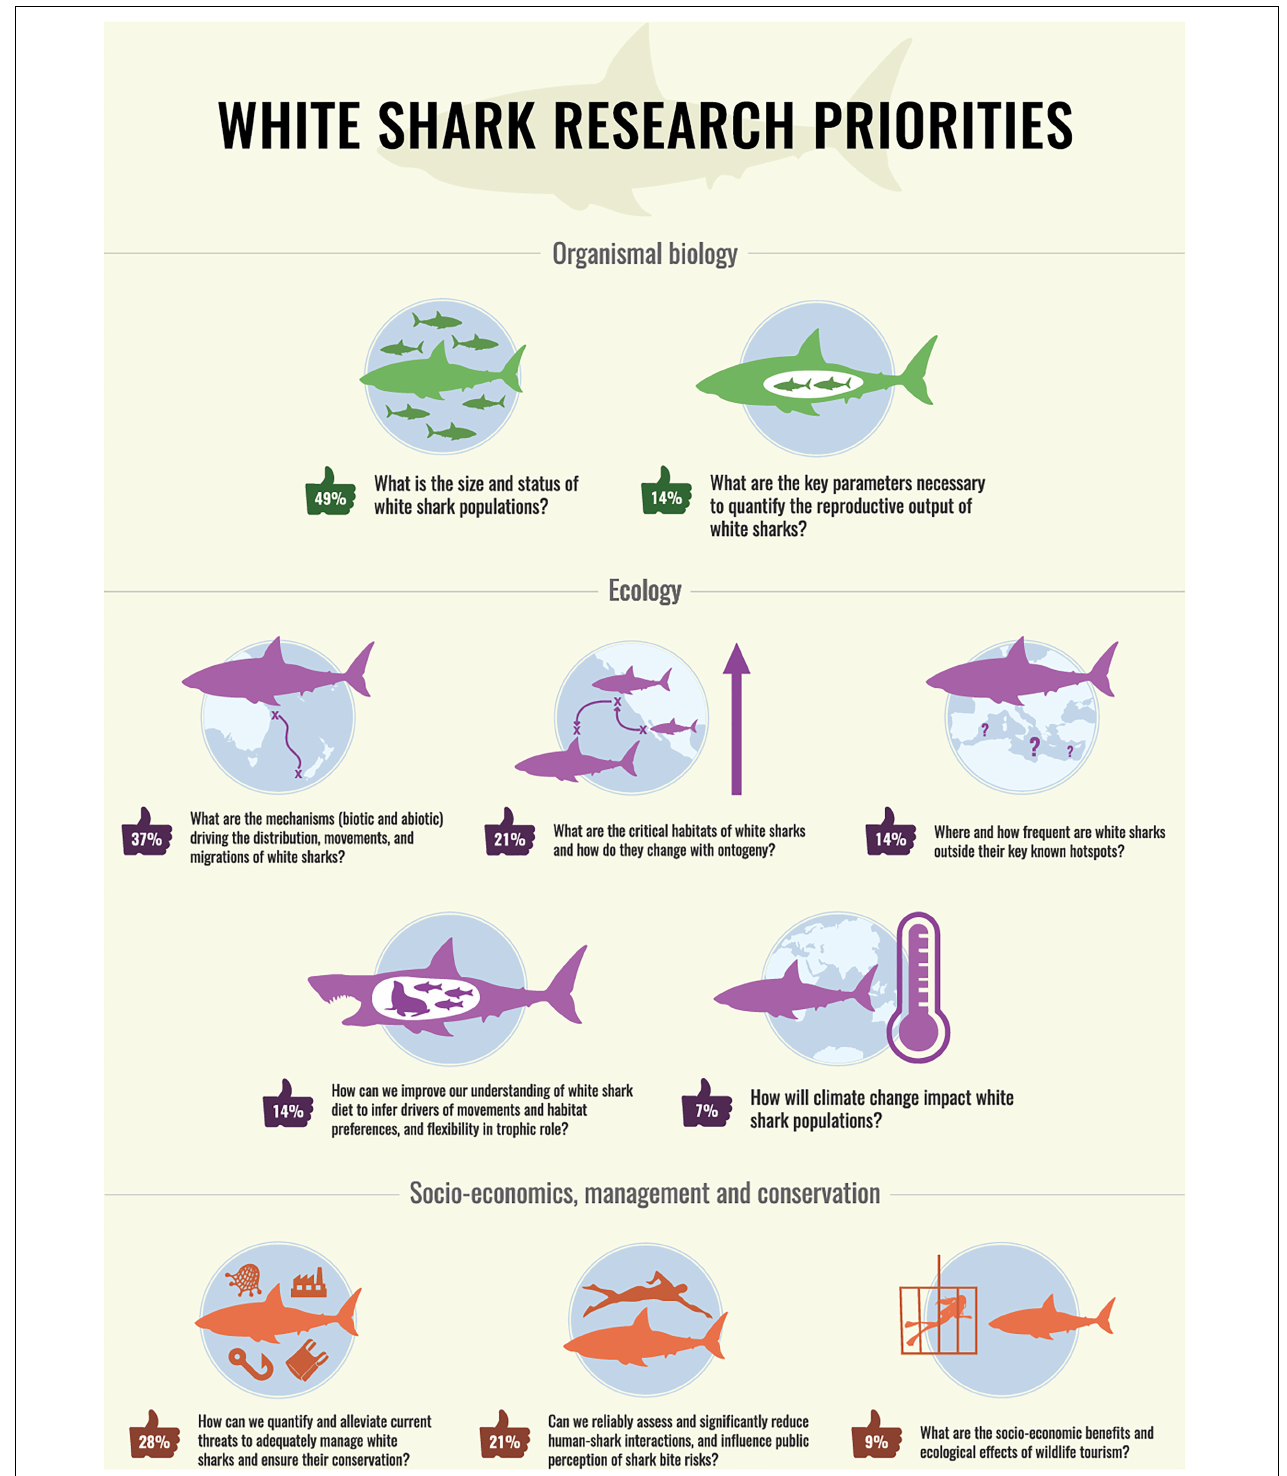
FIGURE 3 | Summary of top 10 research priorities identified by 43 white shark scientists and managers. Priorities are grouped in three categories and ranked in descending order of priority. Number in ‘thumbs up’ represents the percentage of white shark experts who voted for this research priority. Scientific infographic by David “Ed”